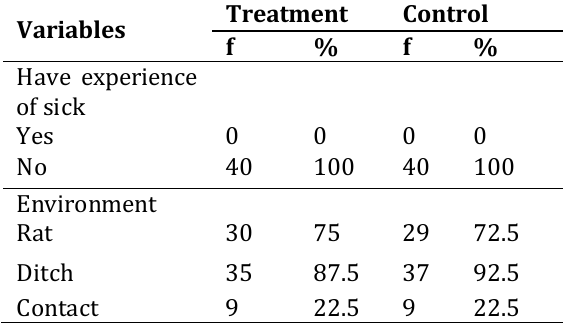
Table 2. Characteristics of Respondents Based on Leptospirosis Risk Factors